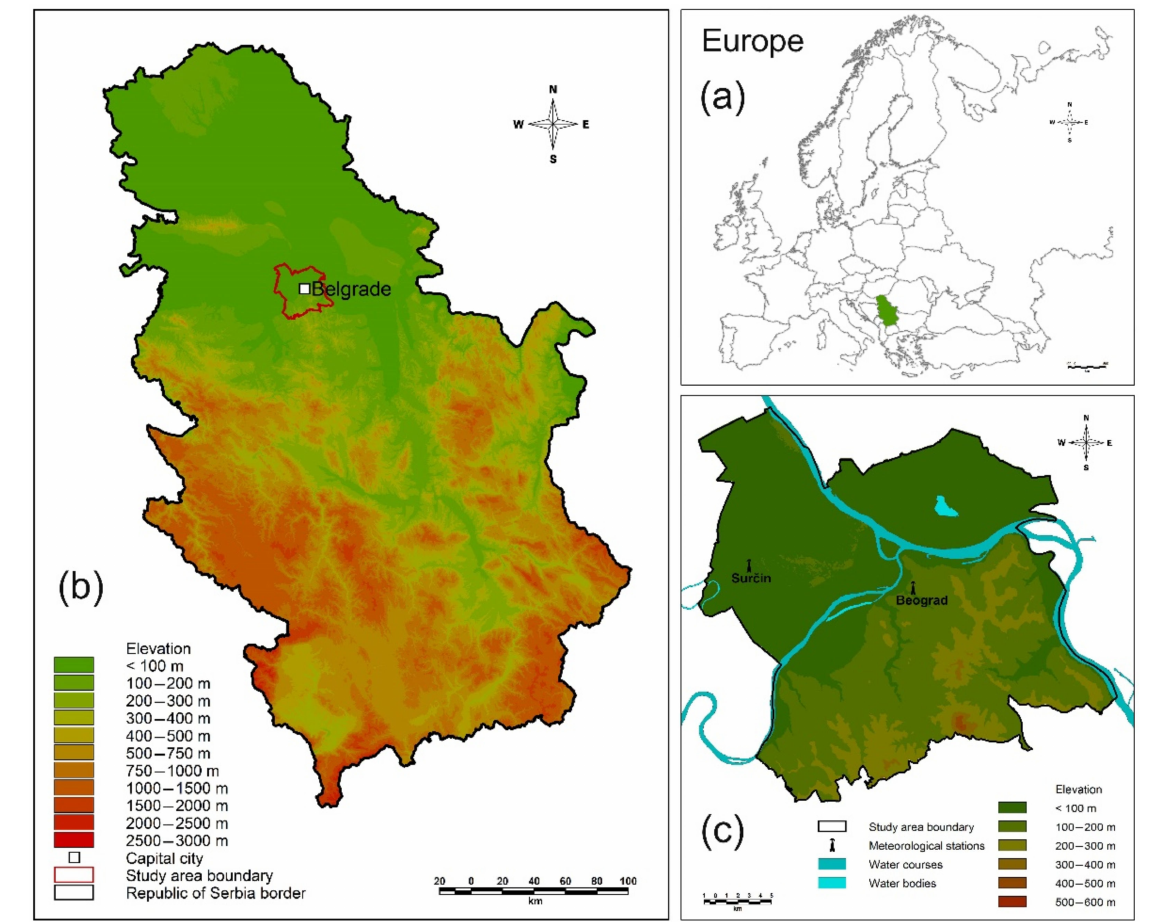
Figure 1. The geographical position of the research area: Serbia’s position in Europe ( a ) Relief map of Serbia ( b ) Relief map of Belgrade ( c